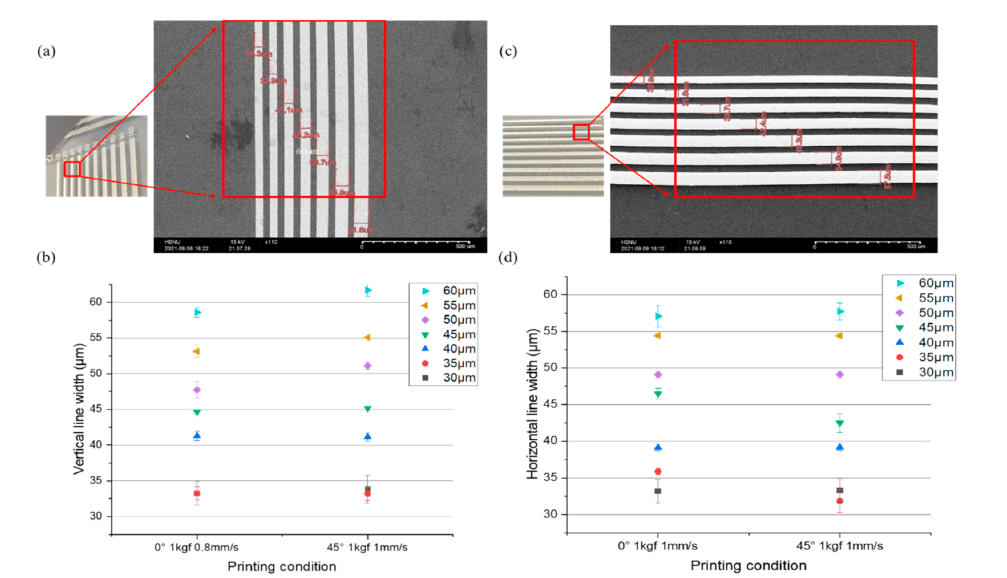
Figure 4. ( a , c ) SEM image of the printed pattern after rotating the clich é by 45 ◦ . ( left : vertical, right : horizontal) ( b , d ) The line width of the pattern printed vertically and horizontally, respectively, without rotating the clich é , and the line width of the pattern printed vertically and horizontally simultaneously by rotating the clich é by 45 ◦